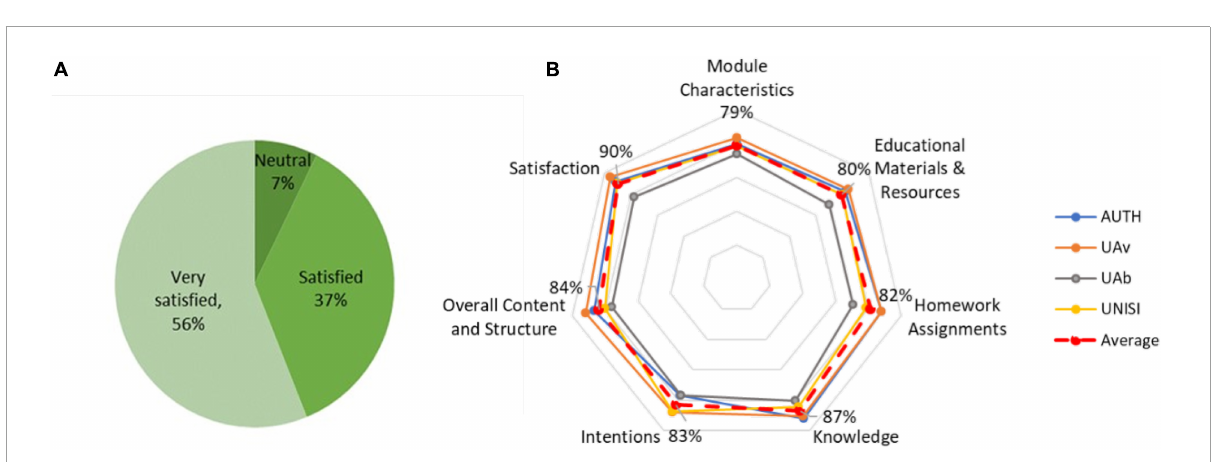
platform and pedagogical model of UAb, the Module had to be adapted (within a few weeks) to be taught as online synchronous sessions at AUTh and UNISI, at a time when